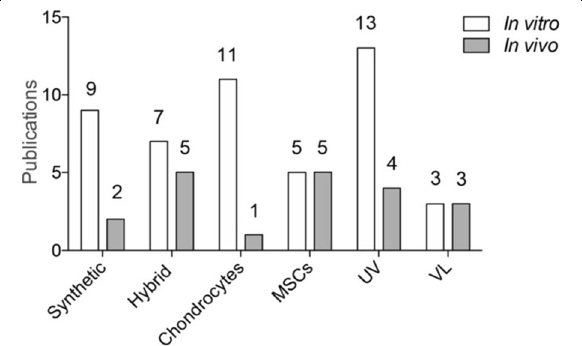
Fig. 2 Current literature available on the use of photopolymerizable hydrogels in cartilage repair research in vitro and in vivo. MSCs, mesenchymal stem cells; UV, ultraviolet; VL, visible